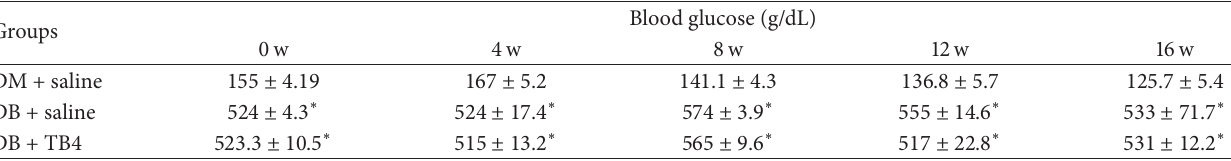
Table 1: Effect of T 𝛽 4 on blood glucose.